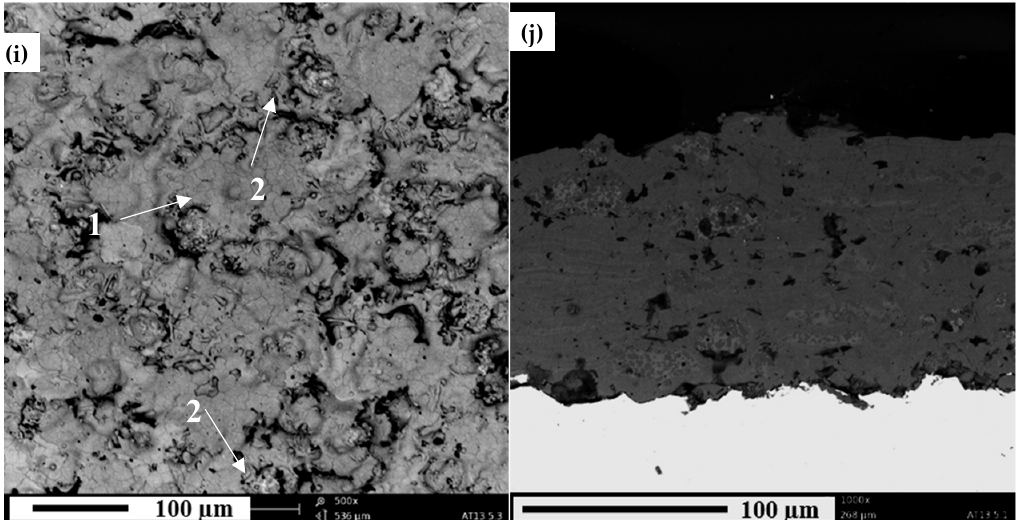
Figure 4. Free surface (left side) and cross sections (right side) of produced coatings: ( a ), ( b ) — AT13-1 (L = 80 mm; V = 300 mm/s); ( c ), ( d ) — AT13-2 (L = 80 mm; V = 500 mm/s); ( e ), ( f ) — AT13-3 (L = 90 mm; V = 400 mm/s); ( g ), ( h ) — AT13-4 (L = 100 mm; V = 300 mm/s); ( i ), ( j ) — AT13-5 (L = 100 mm; V = 500 mm/s); 1 — fully melted splats, 2 — non-melted powder particles.